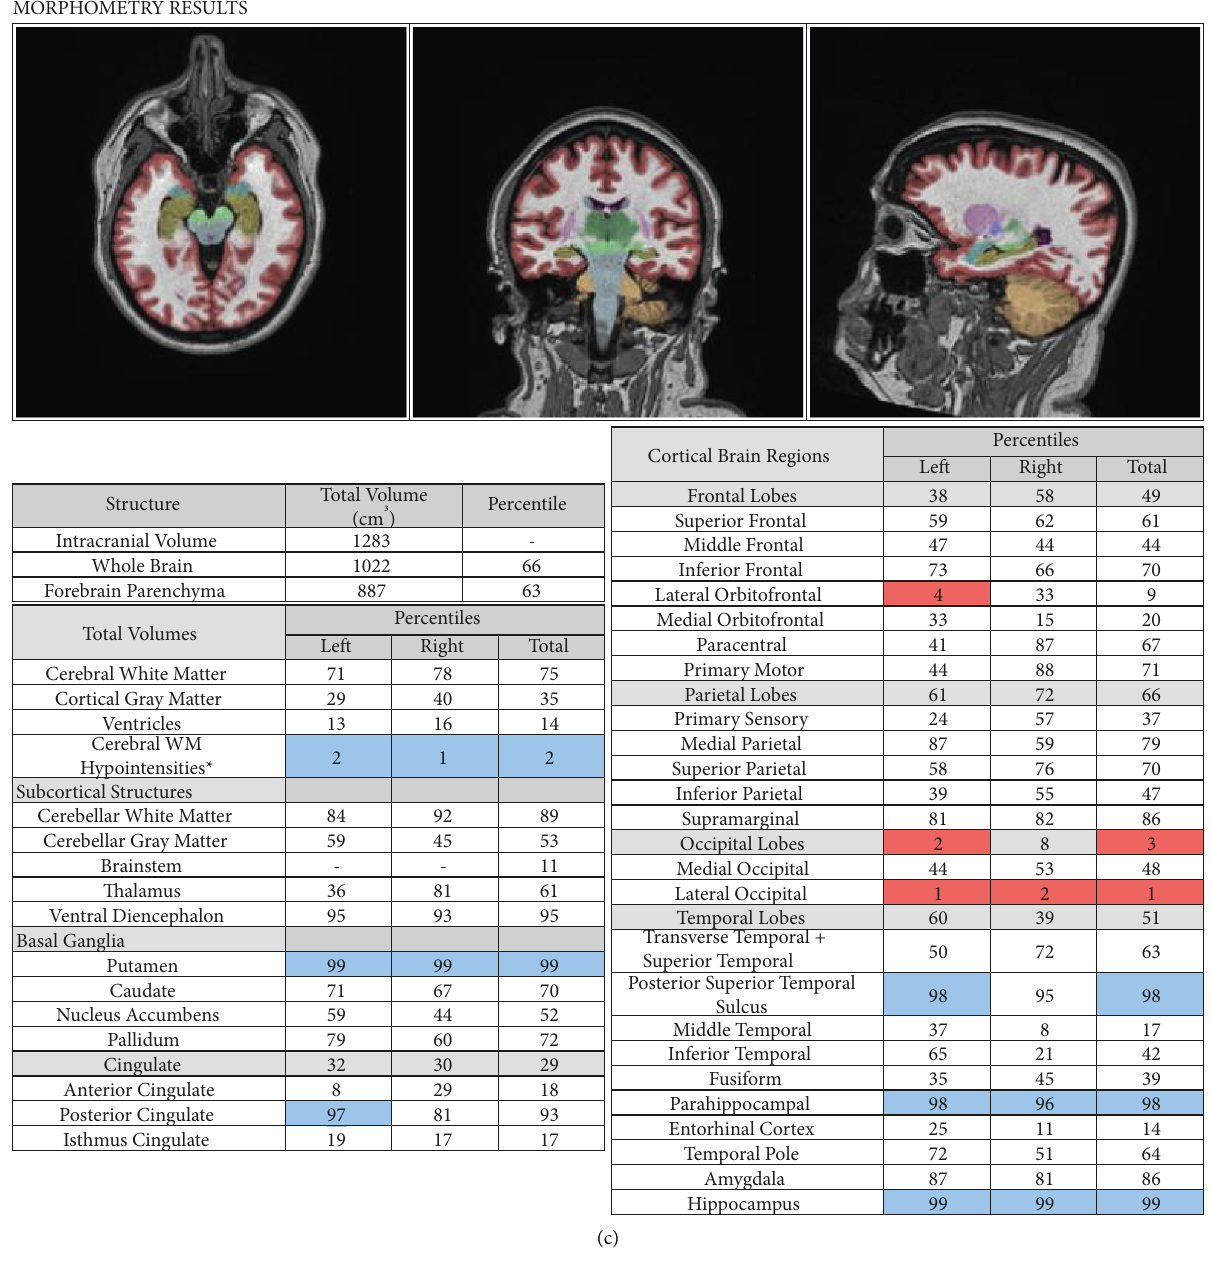
Figure 1: a-c. NeuroQuant report for case